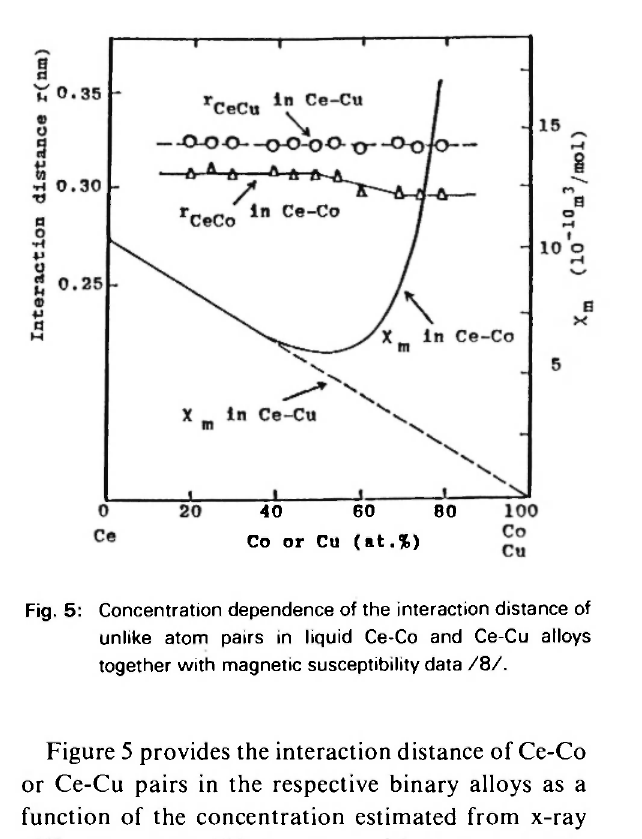
Fig. 5: Concentration dependence of the interaction distance of unlike atom pairs in liquid Ce-Co and Ce-Cu alloys together with magnetic susceptibility data